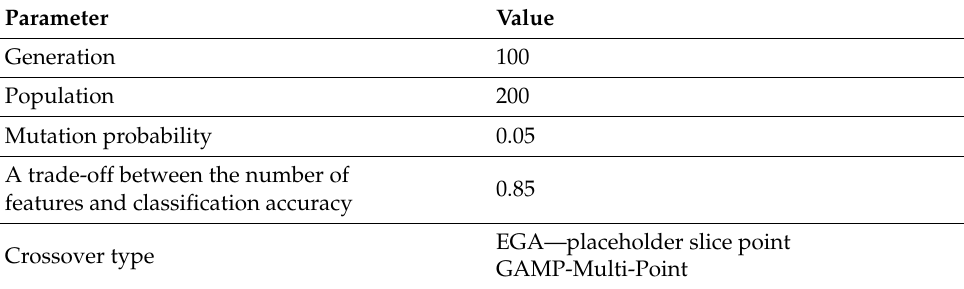
Table 2. Best parameters settings that attained highest Accuracy in EGA.